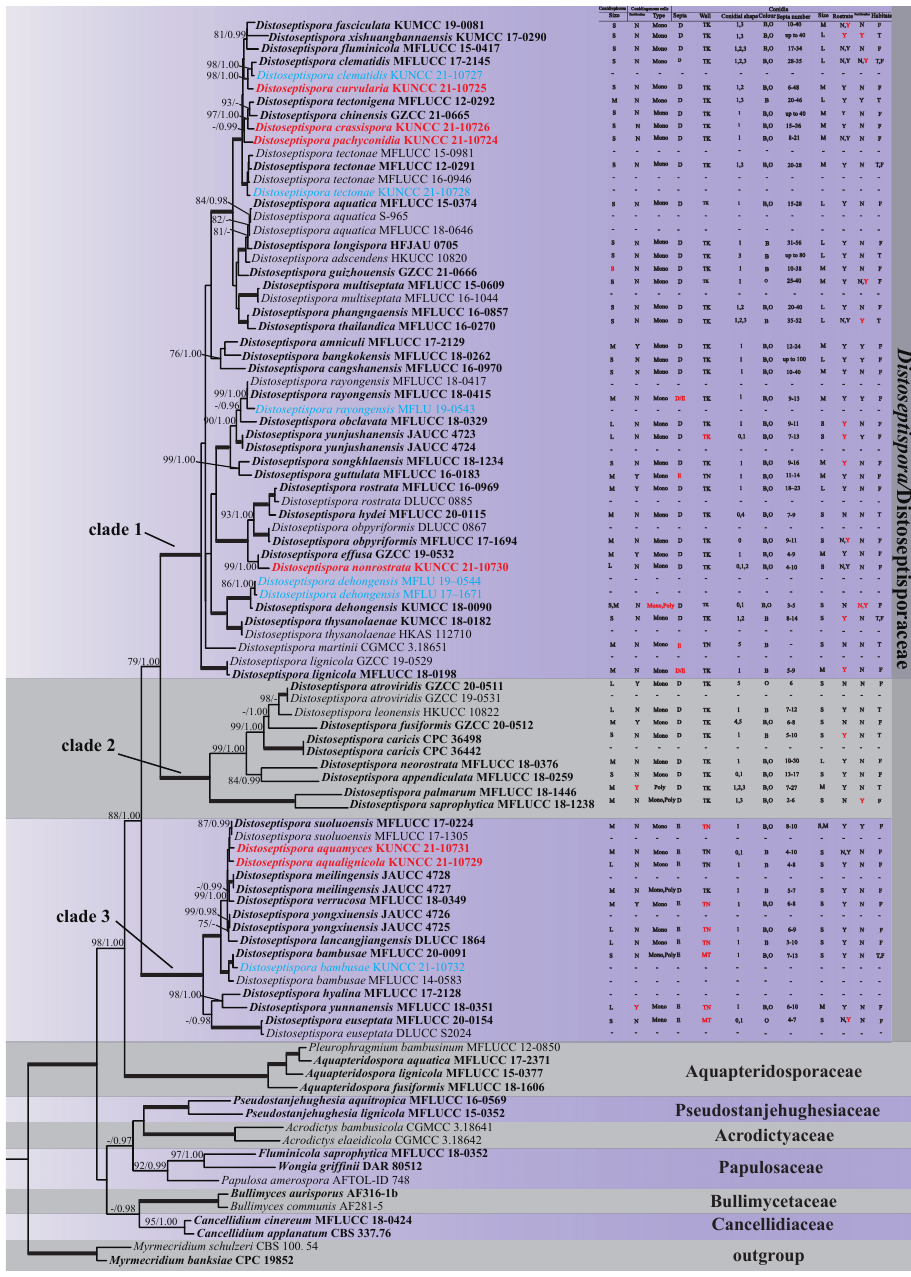
Figure 1. The best-scoring maximum likelihood (RAxML) tree for the family Distoseptisporaceae, based on the LSU, ITS, TEF1 - α and RPB2 sequence dataset. The tree is rooted with Myrmecridium schulzeri (CBS 100.54) and Myrmecridium banksiae (CPC 19852). Maximum likelihood support values greater than 70% and Bayesian posterior probabilities greater than 0.95 are shown near the nodes. New strains identified in this study are shown in blue; new species are shown in red. Ex-type strains are shown in bold. The characters of all Distoseptispora species are summarized, including conidiophores (size: S (maximum length < 100 µ m), L (minimum length > 100 µ m), M (minimum length < 100 µ m and maximum length > 100 µ m)); conidiogenous cells (proliferation: Y (yes), N (no); type: mono (monophyletic), poly (polyphyletic)); and conidia (septa: D (distospetate), E (euseptate); wall: TK (thick), TN (thin), MT (medium thick); conidial shape: 0 (obpyriform), 1 (obclavate), 2 (oblong), 3 (subcylindrical/cylindrical), 4 (fusiform), 5 (ellipsoid, oblate or subglobose); color: B (brown), O (olivaceous or green); septa number; size: S, M and L (the same as for conidiophore size); rostrateness and proliferation: Y (yes), N (no); habitats: T (terrestrial), F